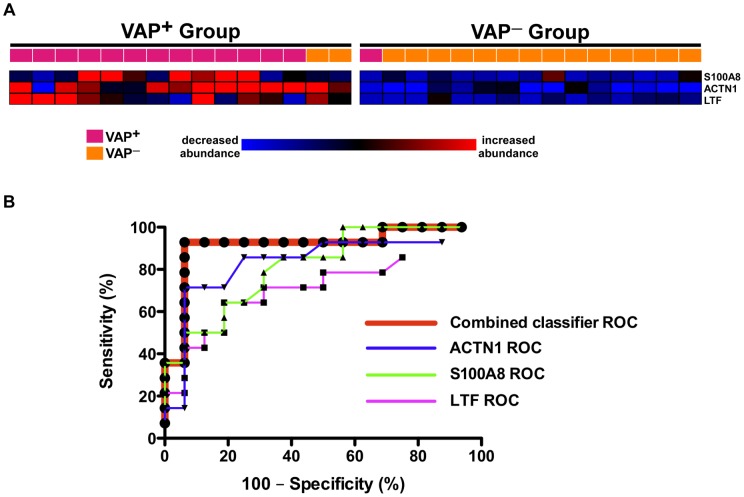
Supervised discrimination analysis integrated with the spectral index method identified a 3-protein signature that robustly segregated VAP+ from VAP–.Panel A: K-median clustering was performed based on the expression profiles of these 3 proteins, resulting in the correct classification of 27 out of 30 patients. Panel B: ROC analysis demonstrates the superior performance of the combined protein classifier compared to each individual member.